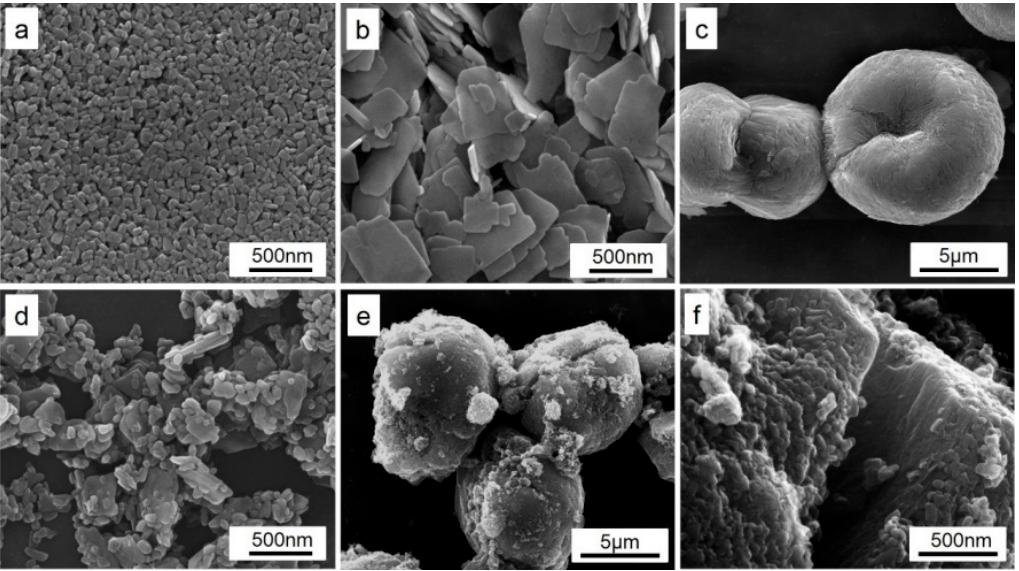
Figure 6. SEM images of LiMnPO 4 and LiFePO 4 with different morphology and as-prepared LiMn 0.4 Fe 0.6 PO 4 : ( a ) LiMnPO 4 nano-plates with lengths less than 100 nm; ( b ) LiFePO 4 plates with lengths around 500 nm; ( c ) a LiFePO 4 micro-sphere with a diameter of over 5 μ m; ( d ) LiMn 0.4 Fe 0.6 PO 4 calcined from a + b; ( e , f ) LiMn 0.4 Fe 0.6 PO 4 calcined from a + c.